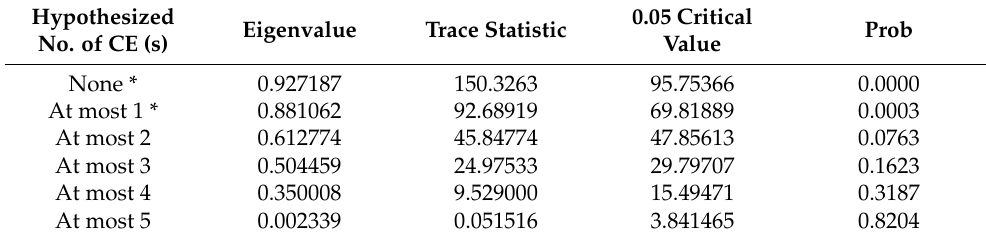
Table A3. Johansen Unrestricted Cointegration Rank Test (Trace).